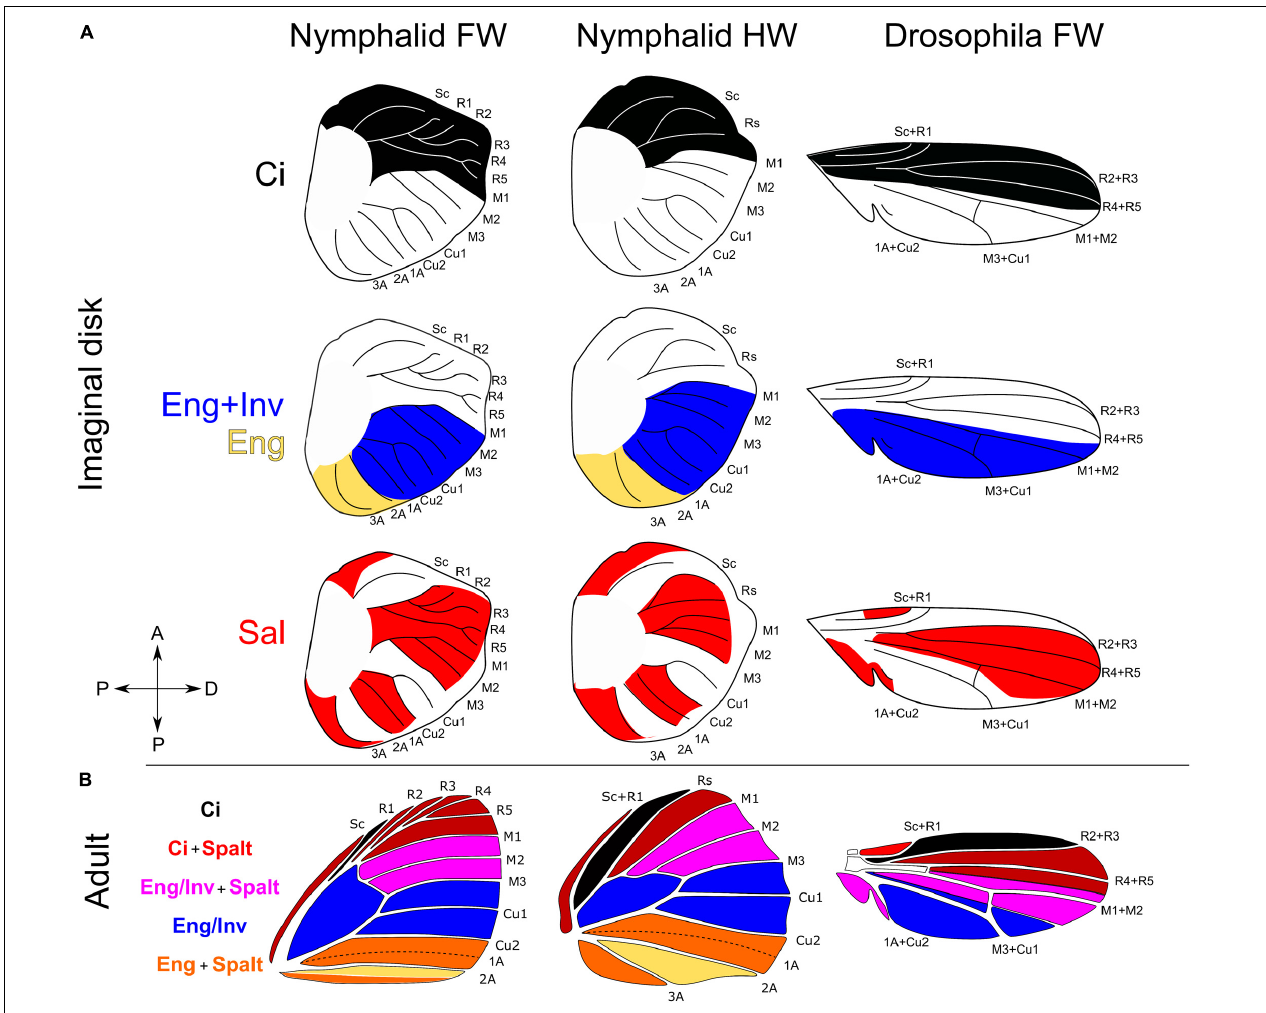
FIGURE 3 | Homology of expression domains of key transcriptional regulators in wing imaginal disks of Nymphalid butterflies and Drosophila melanogaster . (A) Expression of Cubitus interruptus (Ci), Engrailed (En), Invected (Inv), and Spalt (Sal). (B) Superimposing expression domains creates four unique regulatory environments. Ci expression in Nymphalidae from Carroll et al. (1994). Inv and En domains of expression from Banerjee and Monteiro (2020). Spalt expression domains from Reed et al. (2007). Expression data for Drosophila pupal imaginal disks come from Blair (1992) and Milán et al.